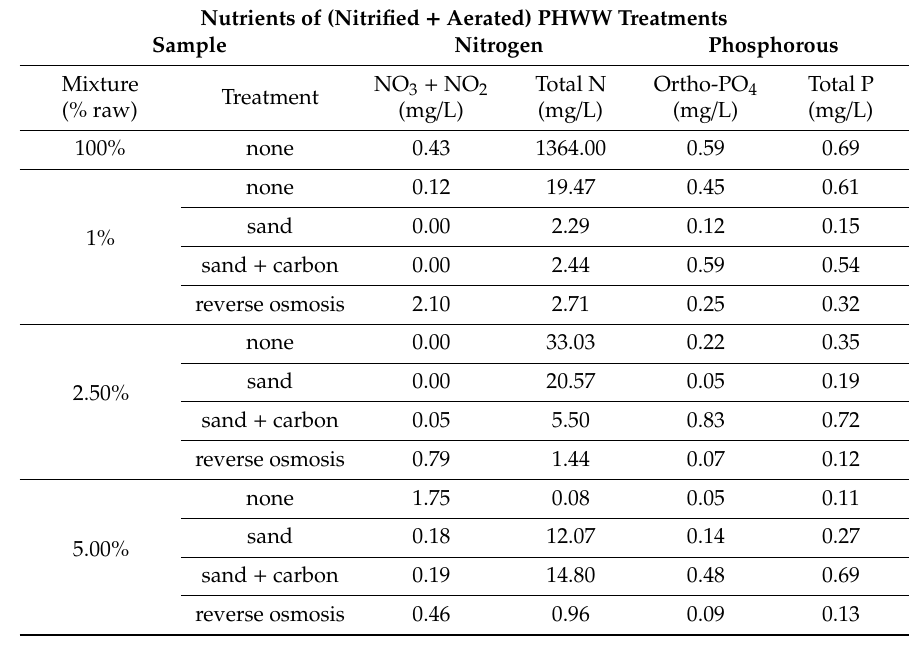
Table 9. Nitrogen and phosphorus concentrations in the raw PHWW and treated PHWW after nitrification. Concentrations are shown in mg/L. The standard deviation from the mean is also presented for each form of nitrogen and phosphorus.